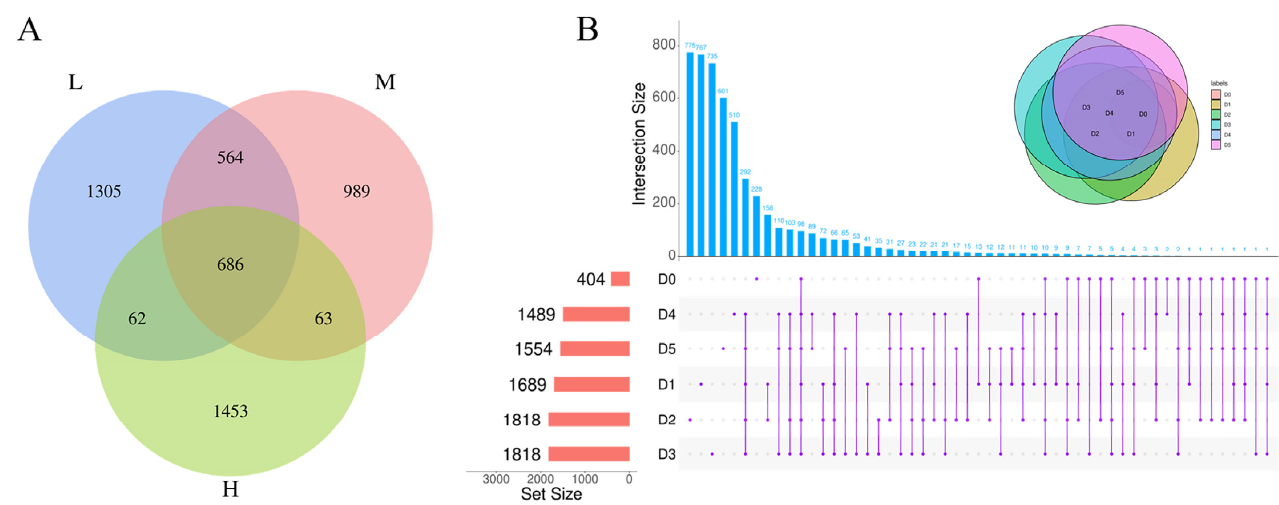
Figure 1. Venn diagram ( A ) and UpSet plot ( B ) based on OTUs of RTE chicken meat bacteria. L, M and H represent samples collected at 4, 8 and 22 °C, respectively. D0–D5 represent samples collected from Day 0 to Day 5.